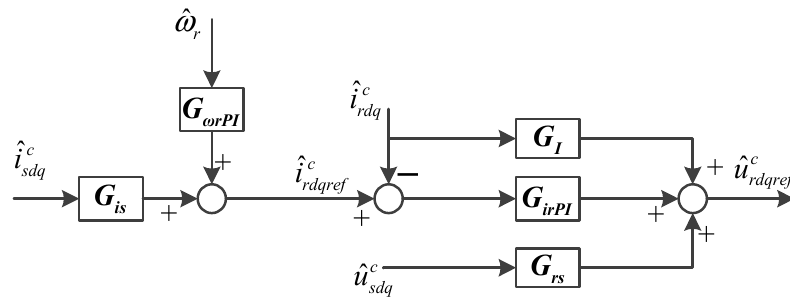
Figure 6. The small-signal transfer diagram of RSC control without PLL in DFIG.